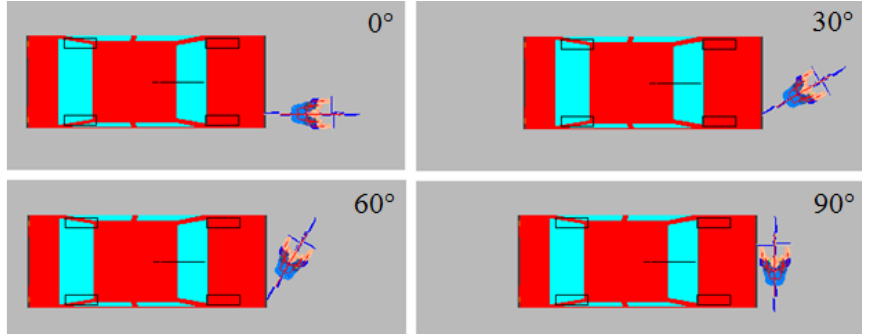
Figure 4. The positions of the car and the cyclist during the impact when the angle of impact was 0°, 30°, 60°, or 90°.